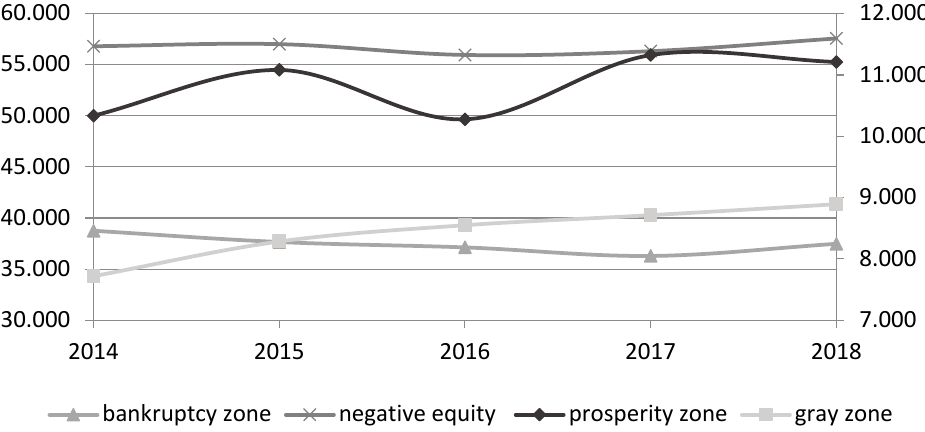
Figure 10. The relationship between the negative equity and the performance examined according to IN05 index.